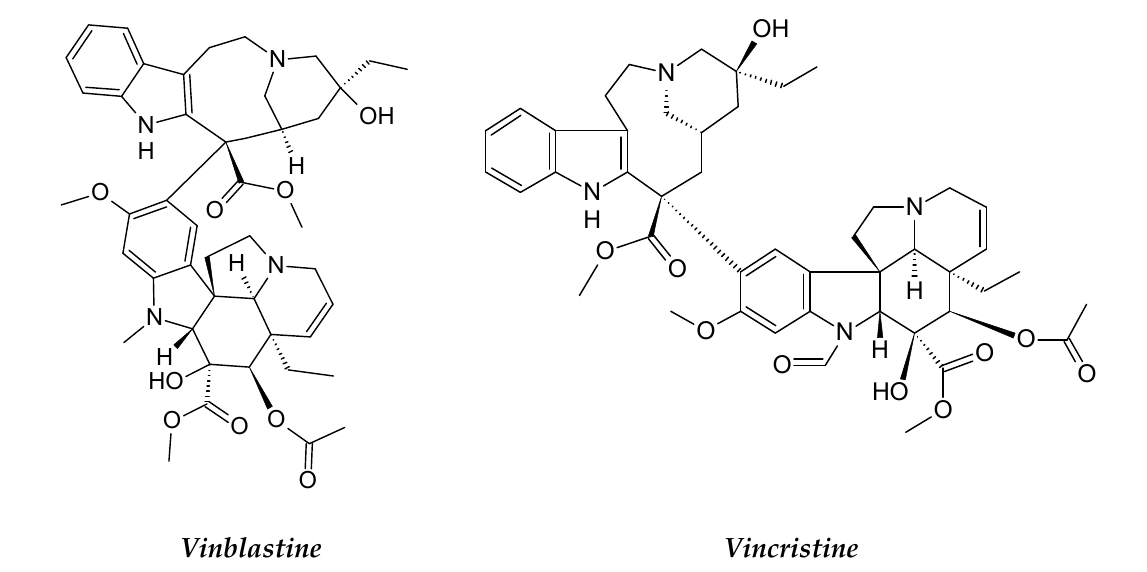
Figure 2. The structures of vinblastine and vincristine.